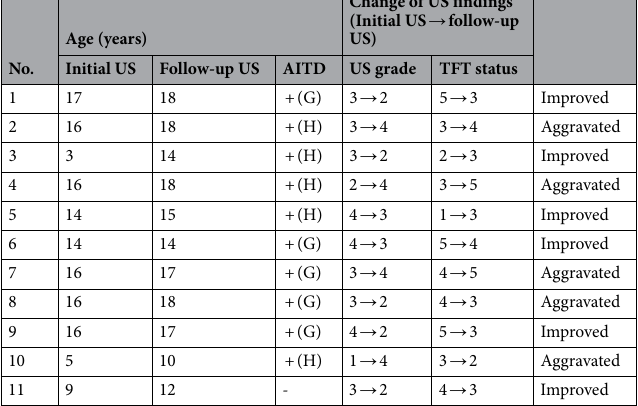
Change of US findings (Initial US → follow-up